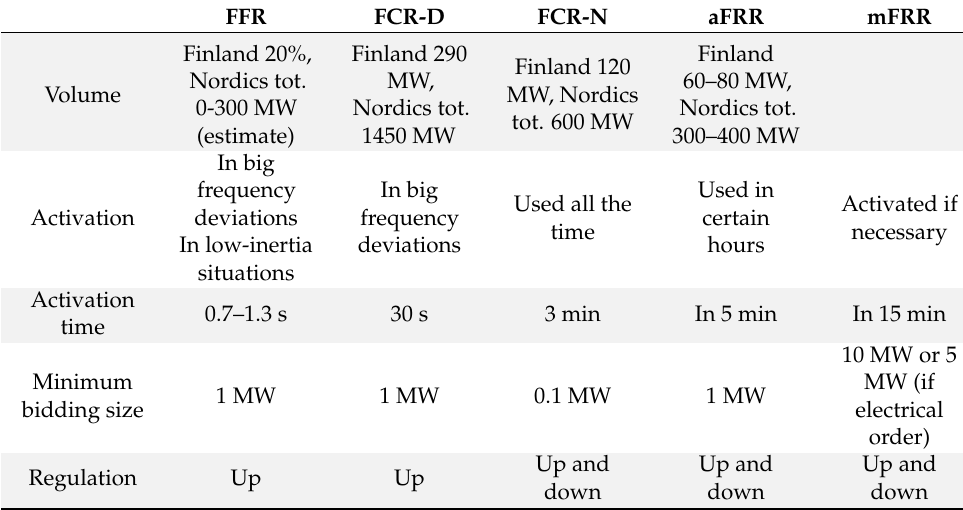
Table 2. Reserve marketplaces in Finland